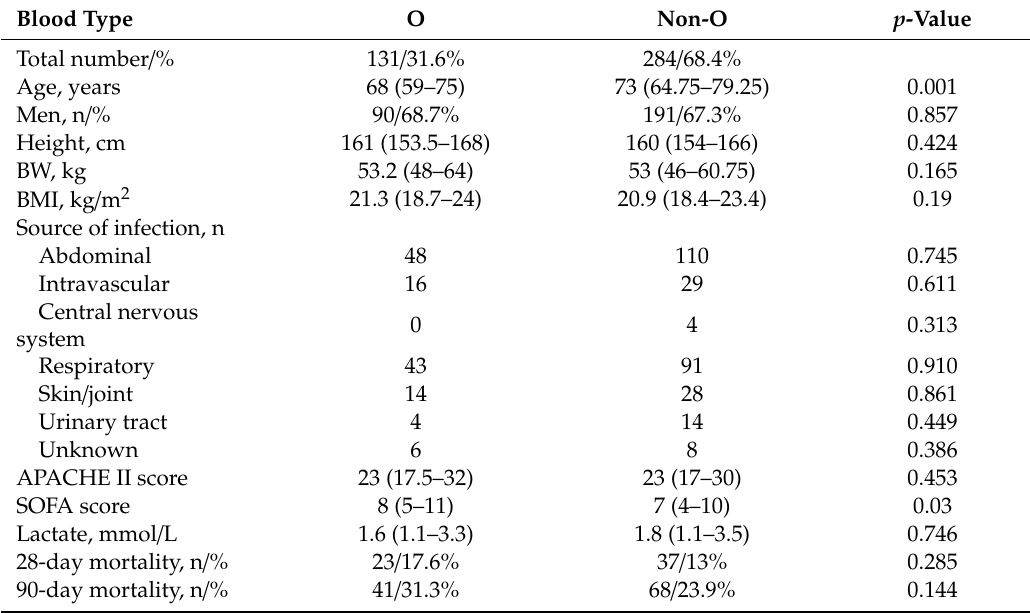
Table 2. Comparison of baseline characteristics between patients with blood type O and other blood types among the study cohort.